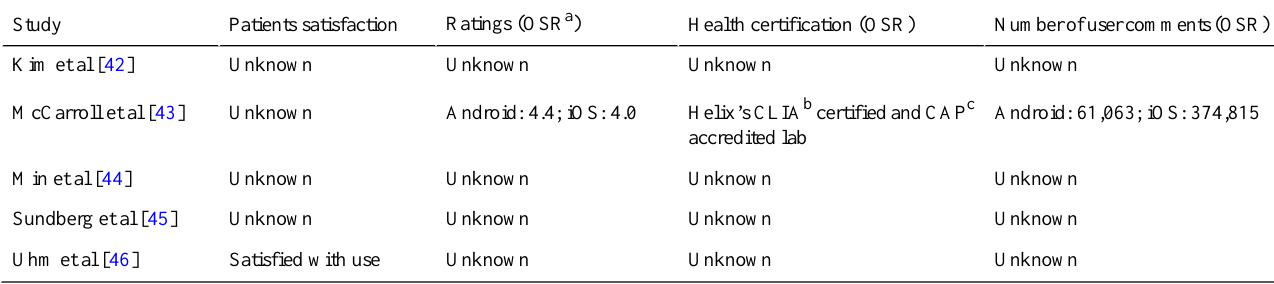
Table 4. Patient satisfaction levels provided by the health literature review and the online store search